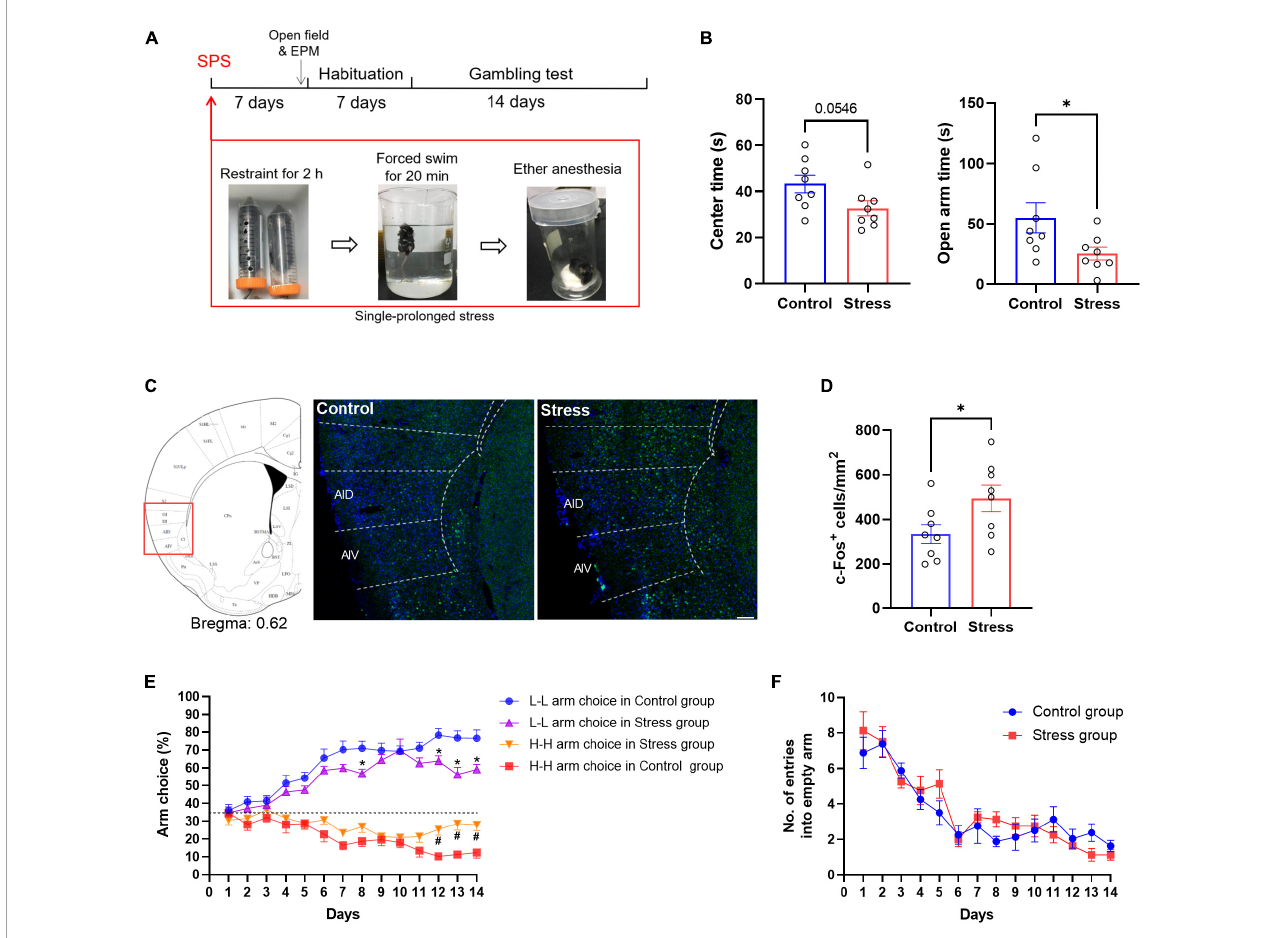
FIGURE2 SPS alters the risk decision-making of mice. (A) Experimental scheme. Mice were subjected to SPS 7 days before the decision-making task. (B) Performance of stressed mice in the open field and EPM test. (C,D) Fos immunostained sections of AIC from control and stressed mice and the numbers of Fos+ neurons were analyzed in two groups. n = 8 mice per group. Data are presented as means ± SEM. ∗ P < 0.05, Scale bar = 100 µ m. (E) Performance of stressed mice in the gambling test. A dotted line indicates the level of chance for arm choice. ∗ P < 0.05 vs. the L-L arm choice in control group ( post-hoc Tukey’s test, P = 0.0396 on day 12, P = 0.0136 on day 13, P = 0.0381 on day 14), # P < 0.05 vs. the H-H arm choice in control group ( post-hoc Tukey’s test, P = 0.0092 on day 12, P = 0.0070 on day 13, P = 0.0220 on day 14). (F) Effect of stress on the number of entries into empty arms. There were no significant main effects [treatment: F ( 1 , 14 ) = 0.1623, P = 0.69; time: F ( 13 , 182 ) = 25.30, P < 0.05; interaction: F ( 13 , 182 ) = 1.134, P =